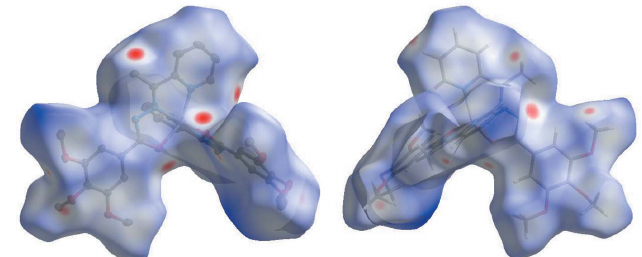
Figure 3 Two projections of d norm mapped on Hirshfeld surfaces, showing the intermolecular interactions within the molecule. Red areas represent contacts shorter than the sum of the van der Waals radii, while blue areas represent regions where contacts are larger than the sum of van der Waals radii, and white areas are zones close to the sum of van der Waals radii.